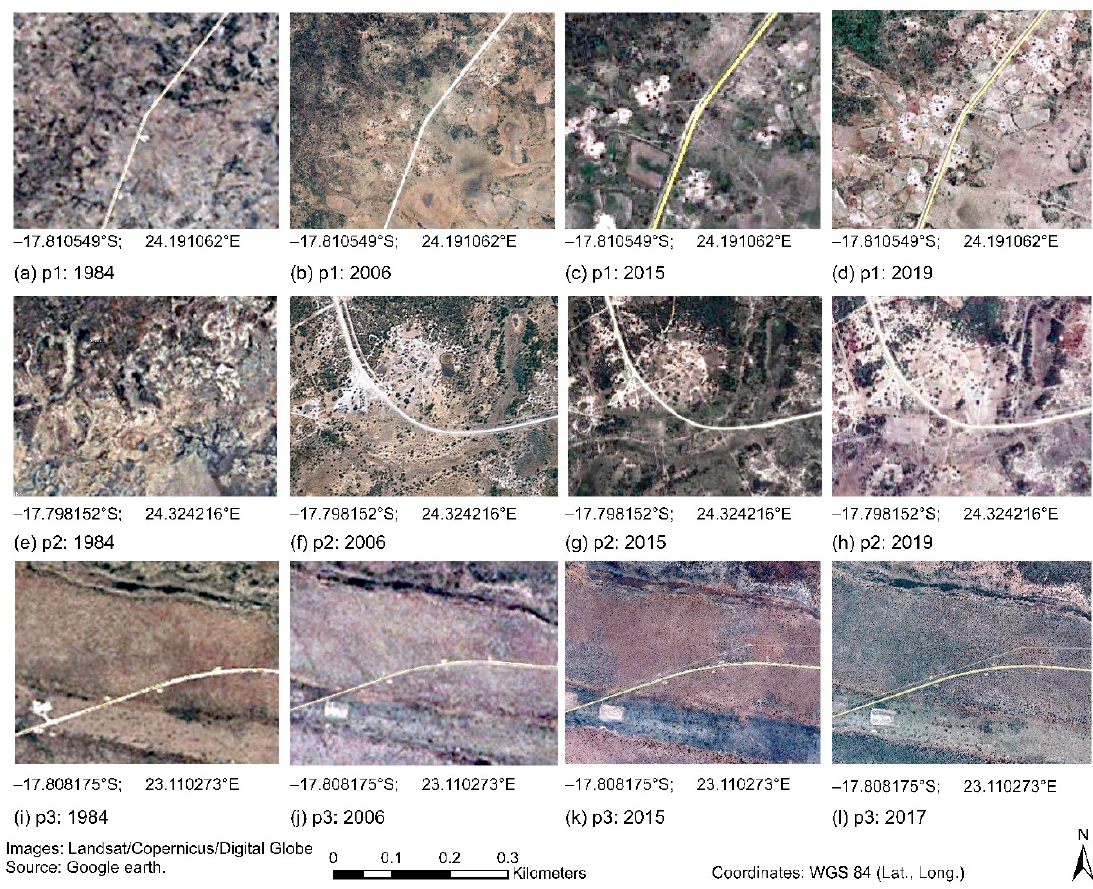
Figure 4. Visual comparison of historical images from select pixels where vegetation cover change was occurring across the Zambezi Region in 1984 and 2015. These locations (p1–p3) correspond to the marked pixels in Figure 3a,b above. p1 shows the approximate location of degraded pixels between 1984 (left-hand column) and 2015 (middle column), covering the period of our NDVI data. The greening pixel (p2) is due to human activity (possibly farms or surface grasses). The right-hand column represents the situation beyond our study period. The location (p3) shows evidence of forest regeneration. We used images on December 31 for 1984 and 2015. For the images in the third column on the right, we used the best quality images closest to the same altitude as in 1984 and 2015.